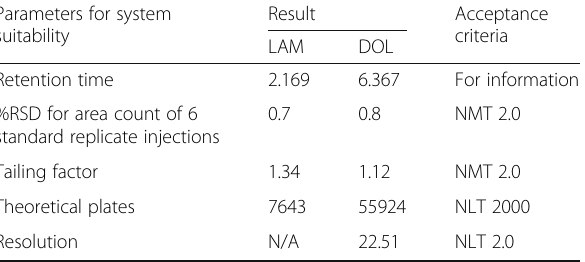
Table 1 Results of system suitability